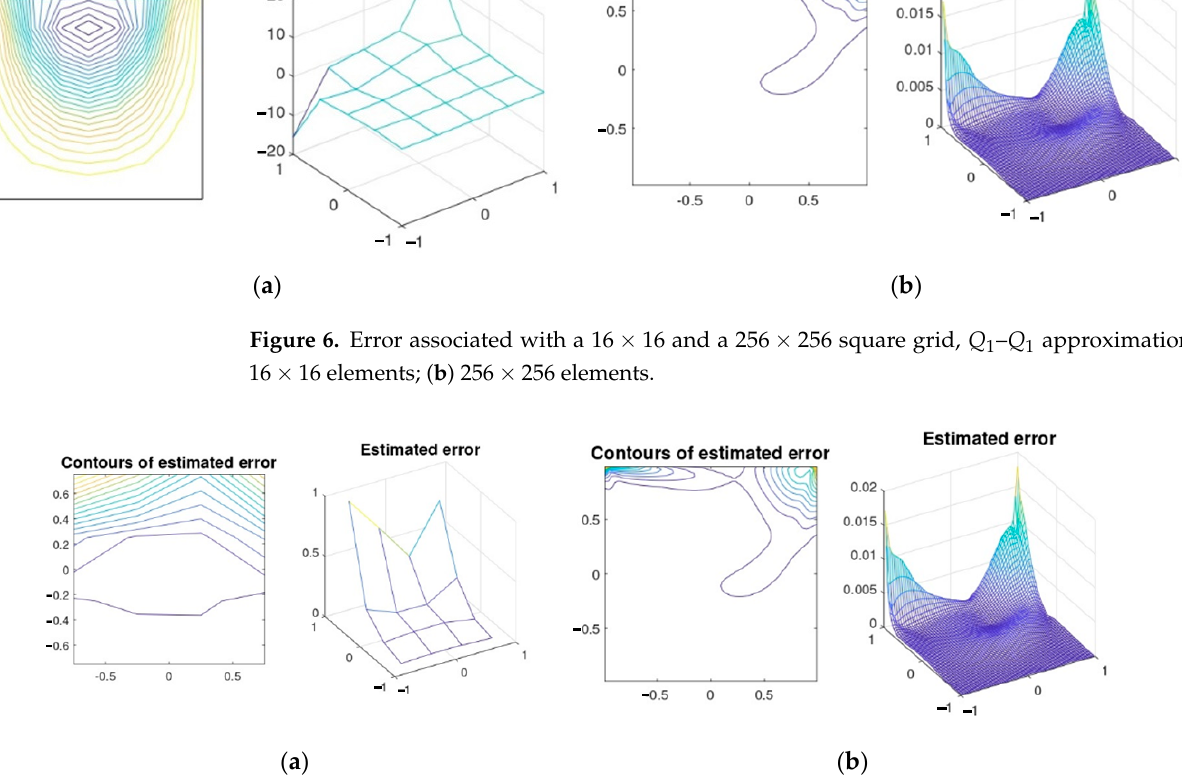
( b ) Figure 8. Error associated with a 16 × 16 and a 256 × 256 square grid, 𝑄 (cid:2870) – 𝑄 (cid:2869) approximation. ( a ) 16 × 16 elements; ( b ) 256 × 256 elements. ( a ) ( b ) Figure 9. Error associated with a 16 × 16 and a 256 × 256 square grid, 𝑄 (cid:2870) – 𝑃 (cid:2869) approximation. ( a ) 16 × 16 elements; ( b ) 256 × 256 elements. In the previous fi gures, we can notice that the results are well-presented if we take the mesh to be very small. Table 1 represents the residual error estimator 𝜂 , the estimated velocity divergence error ∥ ∇ ⋅ 𝑢⃖(cid:4652) (cid:3035) ∥ (cid:2868),(cid:2960) , and the Stokes solution residual 𝜂 (cid:3020) for di ff erence discretization ( 16 × 16 , 32 × 32 , 64 × 64 , 128 × 128 , and 256 × 256 ) in these elements, cases 𝑄 (cid:2869) – 𝑄 (cid:2869) , 𝑄 (cid:2869) – 𝑃 (cid:2868) , 𝑄 (cid:2870) – 𝑄 (cid:2869) and 𝑄 (cid:2870) – 𝑃 (cid:2869) mixed approximations.